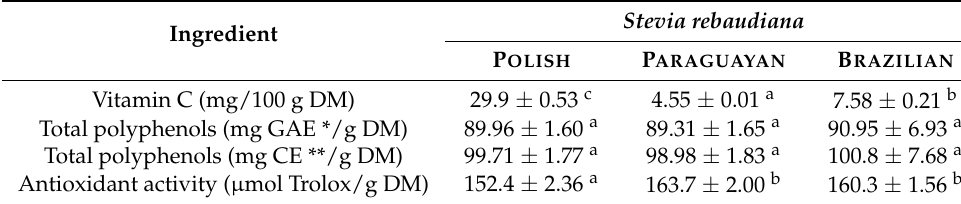
Table 3. Concentration of selected antioxidants in dried leaves of Stevia rebaudiana Bertoni depending on the country of origin. Ingredient